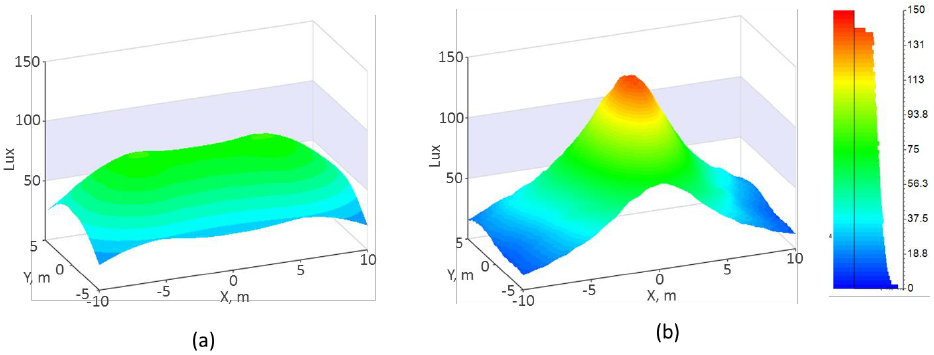
Figure 18. Light distribution of the street lamp on the road surface using: ( a ) our proposed design and ( b ) typical LED street lamp based on freeform optics.